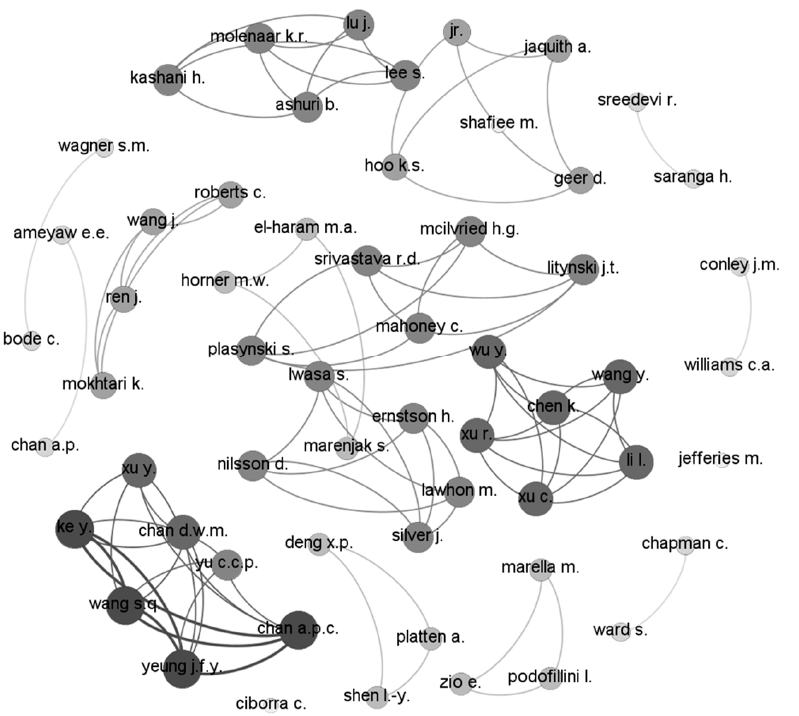
Figure 4. Collaboration network of authors.